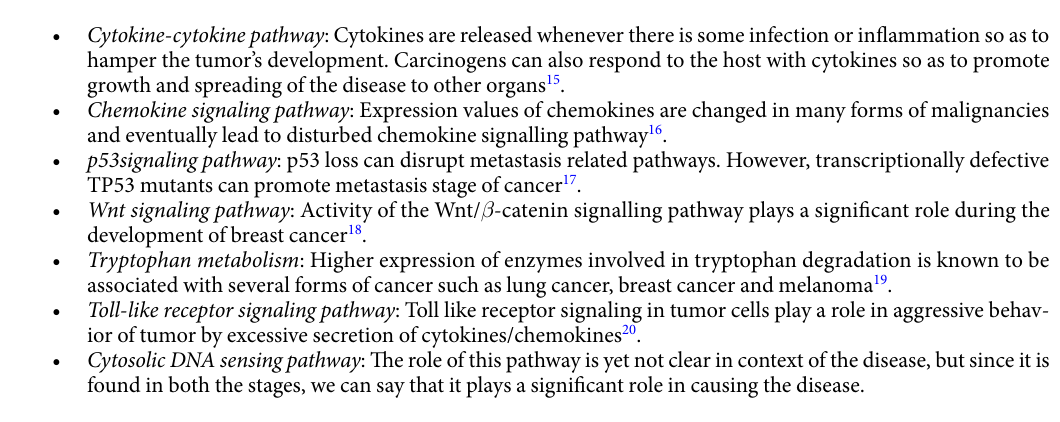
Figure 3. Common genes found among the modules in both the